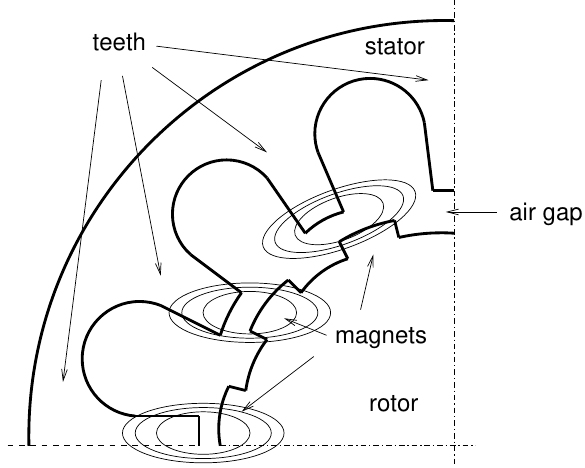
Figure 3. Schematic representation of the magnetic interaction between stator and